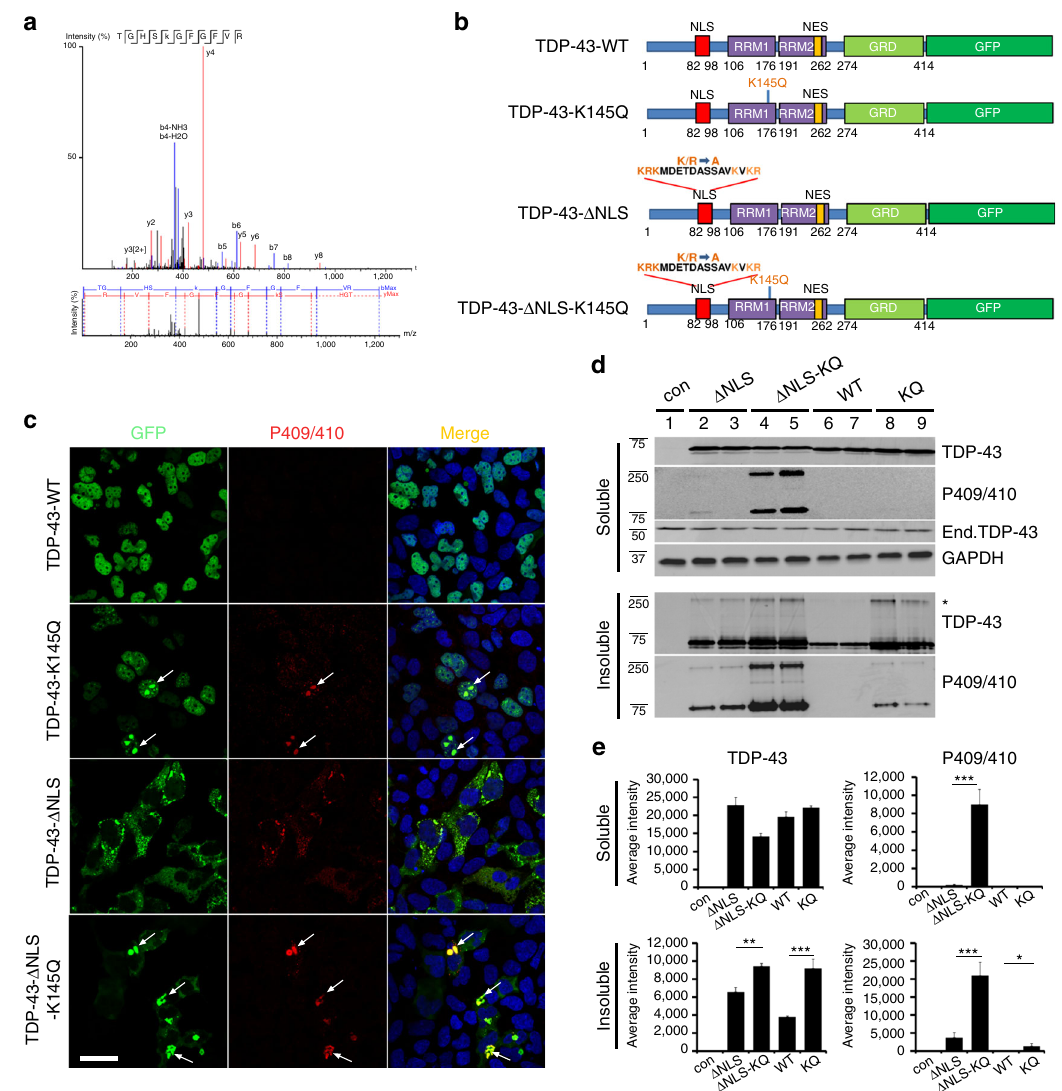
Fig. 1 TDP-43 acetylation-mimics promote TDP-43 aggregation in cells. a QBI-293 cells expressing TDP-43- Δ NLS in the absence of ectopic acetyltransferases were analyzed by mass spectrometry, which identi fi ed the K145-acetylated peptide. b A schematic diagram of GFP-tagged TDP-43 constructs used in this study. Basic residues ( light brown ) within the bipartite nuclear localization sequence (NLS) were mutated to generate cytoplasmic TDP-43 (TDP-43- Δ NLS). A single glutamine was substituted at position K145 to generate the acetylation-mimic K145Q. c Cells expressing wild-type TDP-43 and TDP-43-K145Q or cytoplasmic localized TDP-43- Δ NLS and TDP-43- Δ NLS-K145Q were analyzed by double-labeling to detect TDP-43 ( green ), phospho-TDP-43 using P409/410 ( red ), and DAPI (blue) to detect nuclei. White arrows highlight highly phosphorylated TDP-43 aggregates. Scale bar = 50 μ m. d Soluble and insoluble fractions isolated from cells expressing the indicated TDP-43 constructs were analyzed by immunoblotting using TDP-43, P409/410, or GAPDH antibodies. Shown is a representative image from N = 3 independent experiments. The asterisk indicates the accumulation of ~75 – 250 kDa TDP-43 species. e Quanti fi cation of TDP-43 and phospho-TDP-43 levels illustrate increased insoluble levels of TDP-43- Δ NLS-K145Q. Error bars indicate SEM and the asterisks indicates statistical signi fi cance with *** p -value < 0.001, ** p -value < 0.01, and * p -value < 0.05, as measured by Student ’ s t -test from N = 3 biological